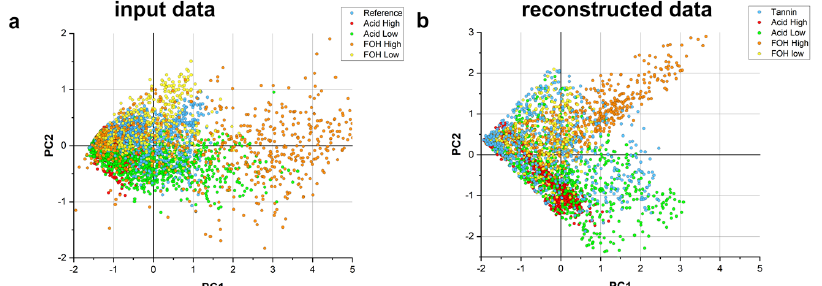
Figure 5. Comparison of the PCA obtained using the input data (panel a ) and the reconstructed data projected and summed along the transversal plane at angle zero (panel b ) PC1 and PC2 are the same for the plots, PC1 0.7 C=C, 0.7 C=O and PC2 0.7 C=C, − 0.7 C=O .